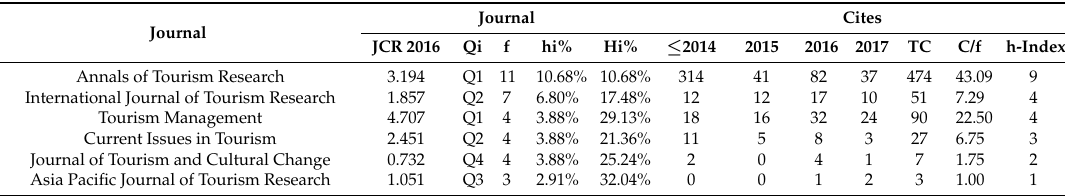
Table 7. Ranking of the most productive magazines.